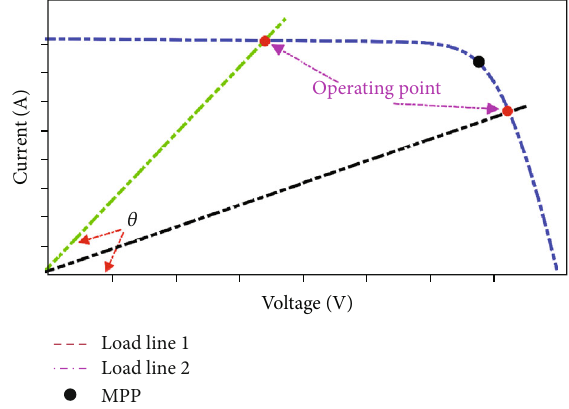
Figure 8: Operating point resulted by a PV module connected with a DC-DC